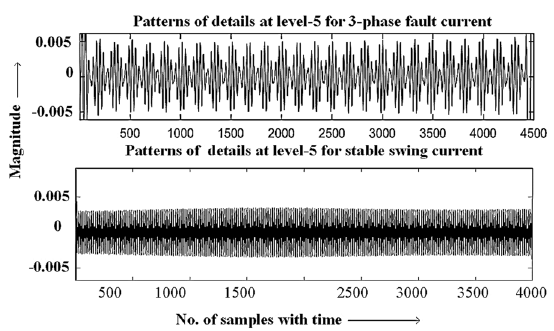
Fig. 4 Pattern difference at level 5 in detail resolution of current during the